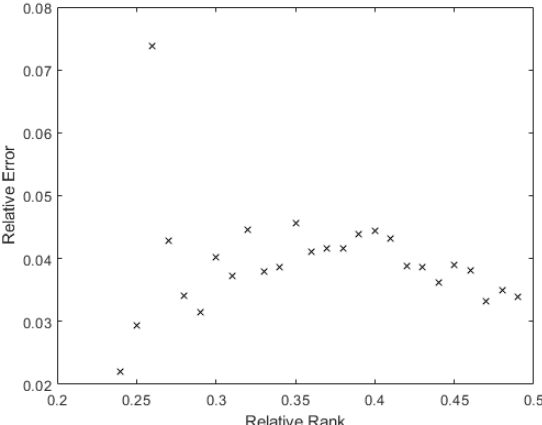
Figure 17. Average value of the relative error according to the relative rank in X 4 .